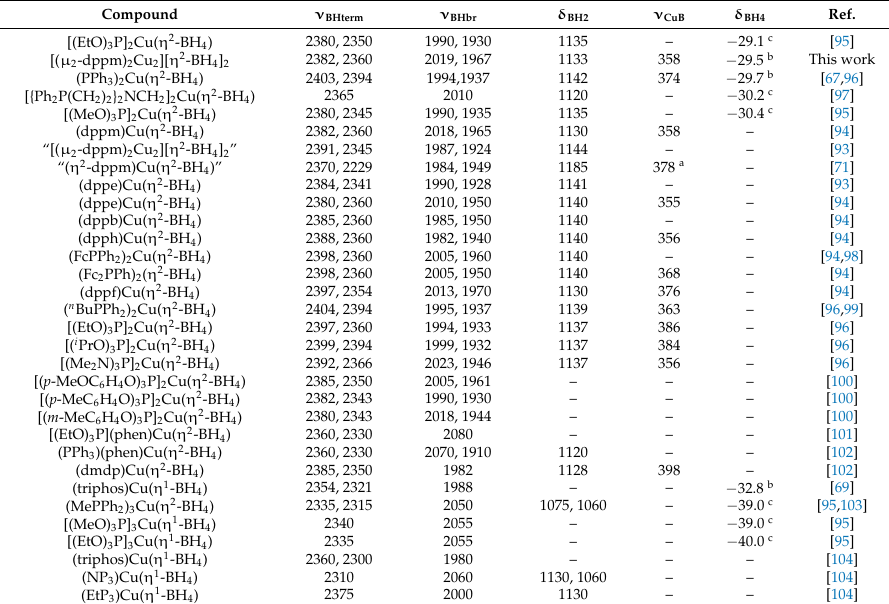
Table 2. Characteristic vibrations observed in IR spectra and 11 B NMR chemical shifts of the BH 4 − group reported for copper(I) tetrahydroborate